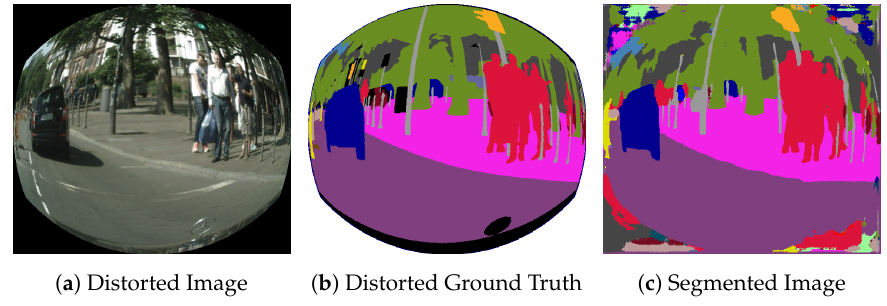
Figure 6. Example of heterogeneous segmentation on the